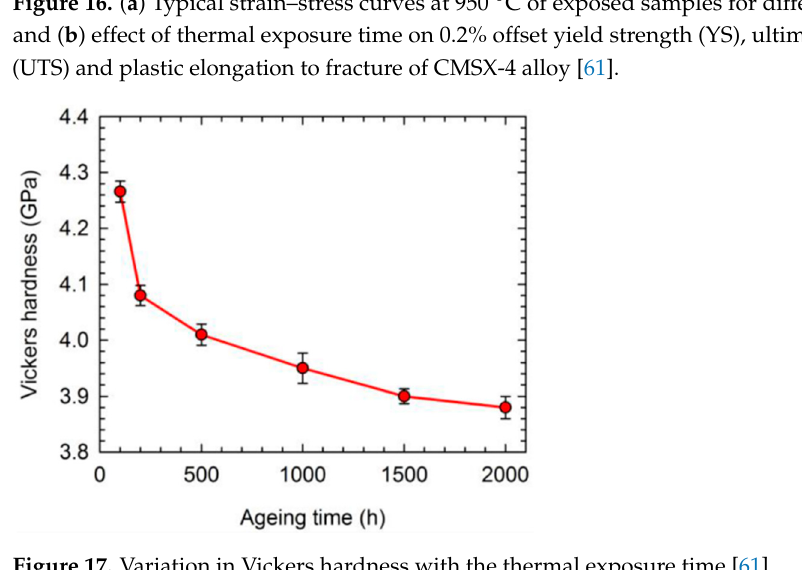
Figure 17. Variation in Vickers hardness with the thermal exposure time [61].